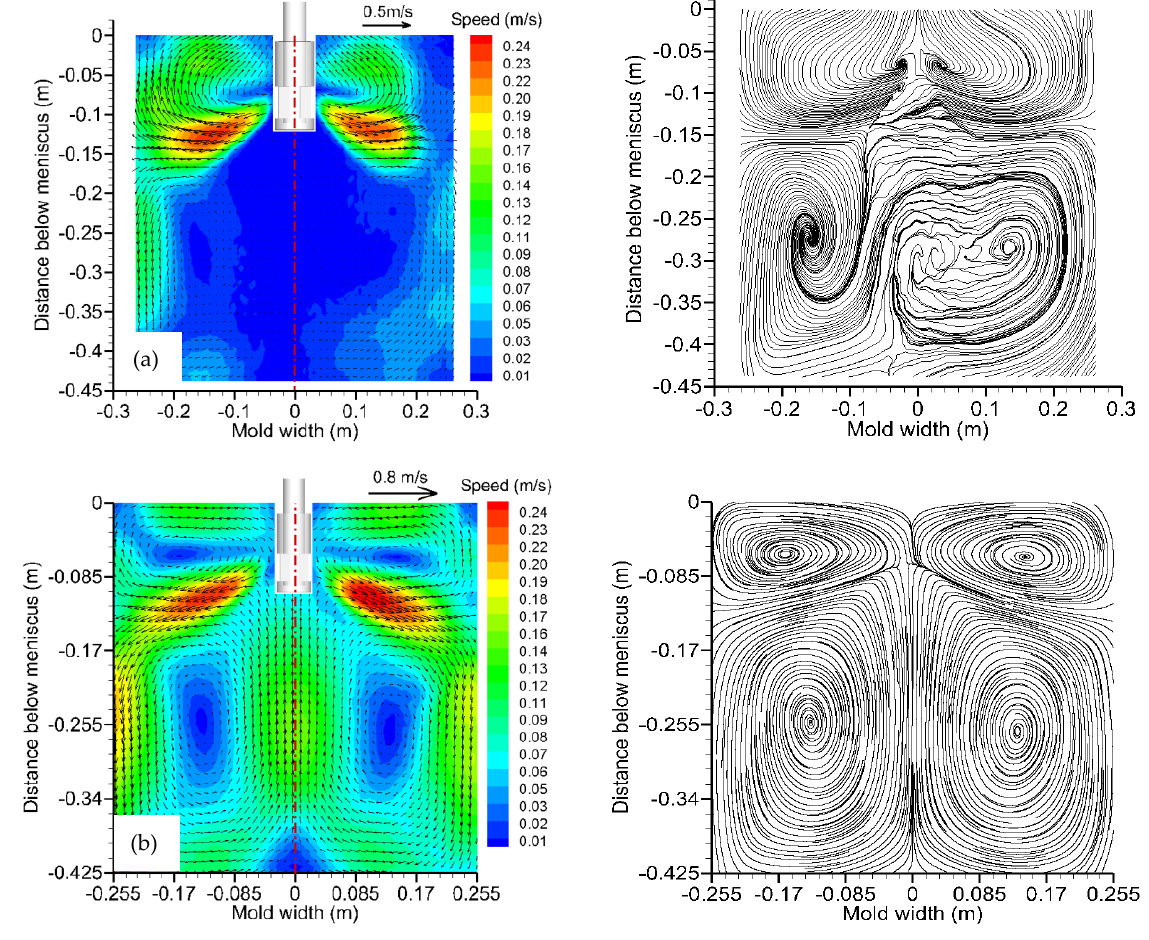
Figure 16. Time-averaged velocity contours, vectors, and streamlines with different gas flow rates. ( a ) The blowing volume is 30 mL·min − 1 , ( b ) no blowing.